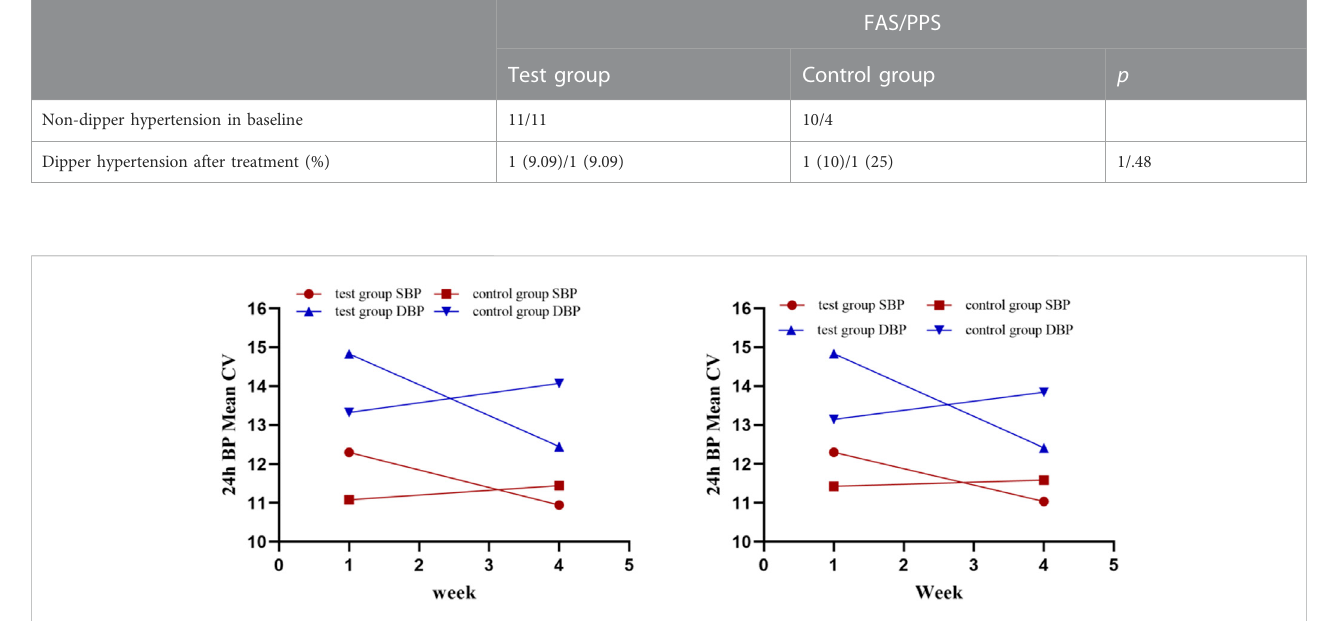
FIGURE 5 24-h BP mean CV (left is FAS; right is PPS).